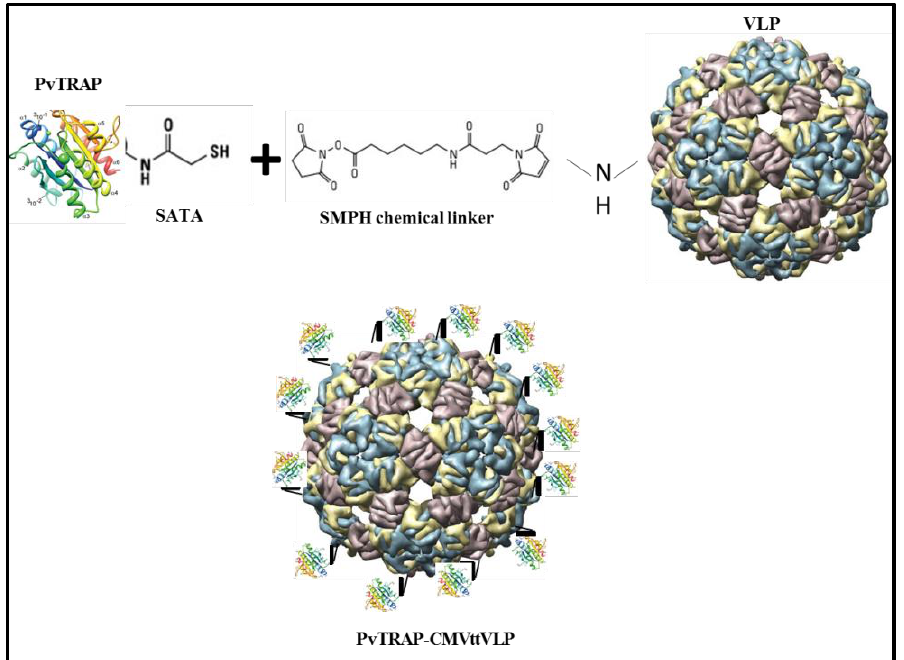
Figure 2. Vaccine preparation scheme: The conjugation of PvTRAP to CMVtt was done by modifying the CMVttVLP with a chemical cross-linker (SMPH) and binding it to modified PvTRAT protein with sulphydryl groups (-SH). SATA: N-succinimidyl-S-acetylthioacetate; VLP: virus-like particle.